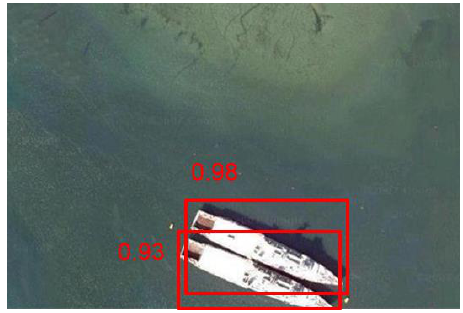
Figure 9. Intersection over the union (IOU) between the prediction box and the ground-truth box.